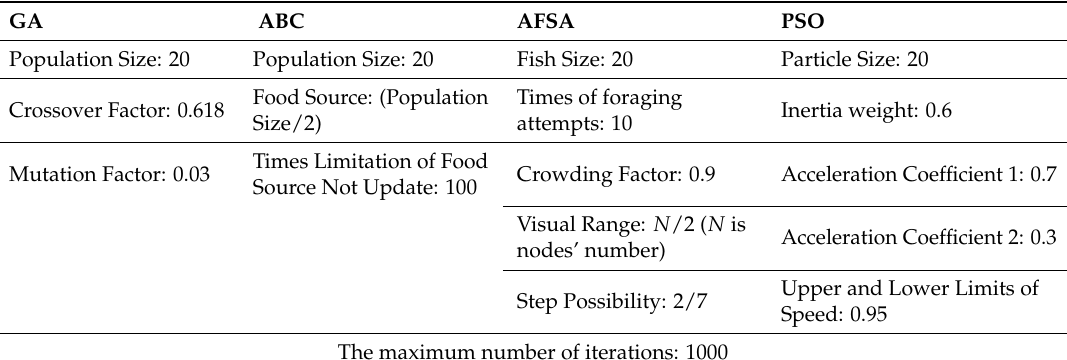
Table 3. Parameter setting of four heuristic